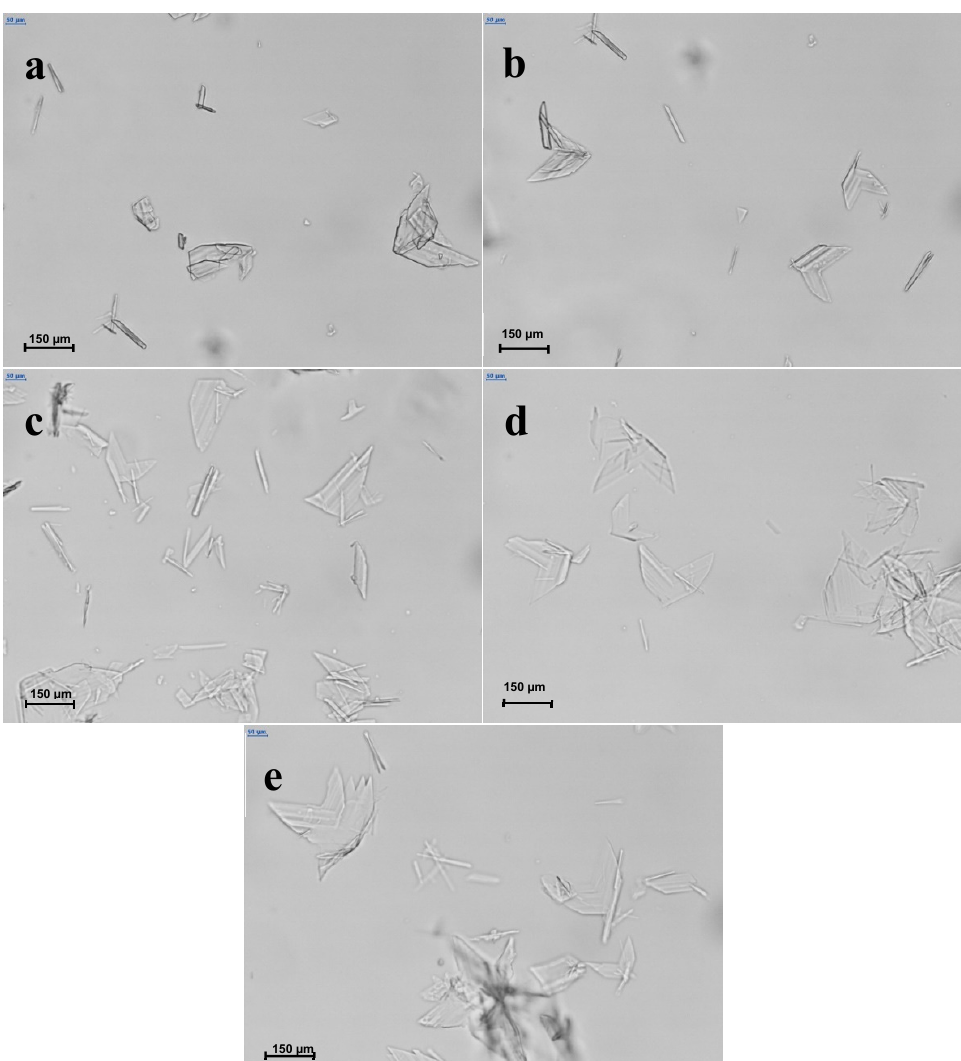
Figure 10. Microscopic photographs (magnification 50 × ) of obtained calcium sulfate dihydrate for C = 0.25 M, T = 298 K and various speeds: ( a ) n = 1.67 s − 1 ; ( b ) n = 3.33 s − 1 ; ( c ) n = 5.00 s − 1 ; ( d ) n = 6.67 s − 1 ; ( e ) n = 8.33 s − 1 .